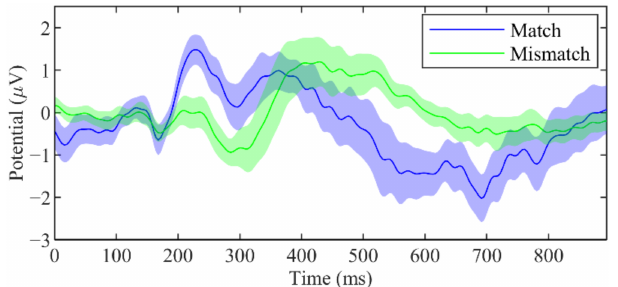
Figure 7. Grand-average waveforms with standard error at Fz in method 1b.